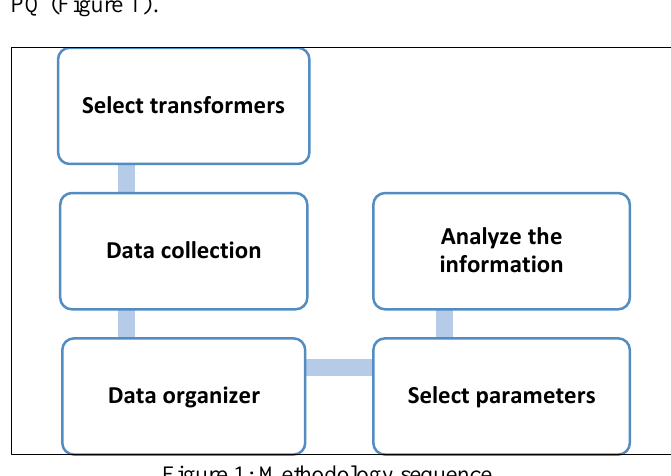
Figure 1: Methodology